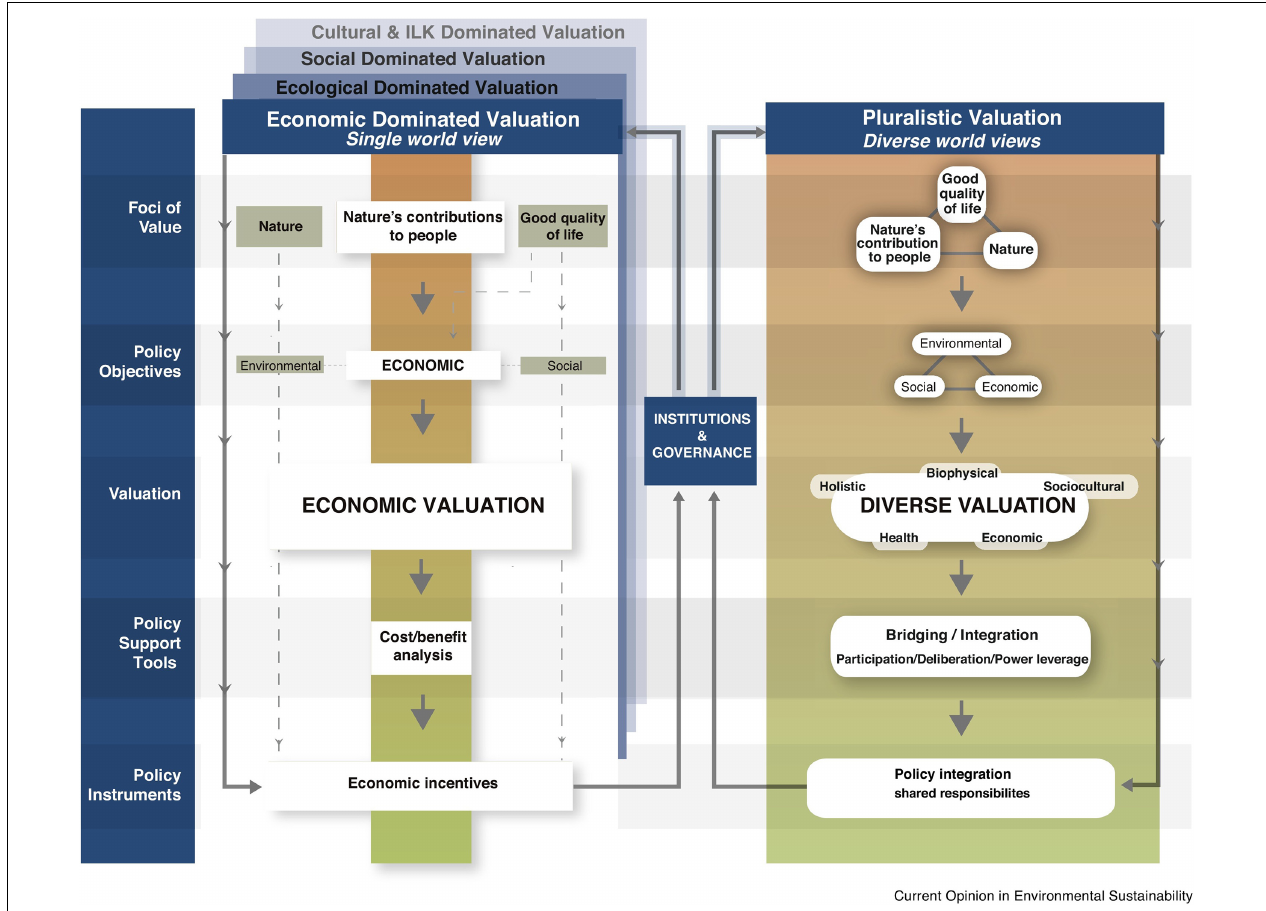
FIGURE 7 | Comparison between two contrasting valuation approaches. The right side represents a pluralistic valuation approach, whereas the left side of the panel focuses on unidimensional valuation approach, which is linked to the long-lasting and rooted idea that valuation equals monetarization. Such misconception generates value gaps which exacerbate social injustice. Reproduced from Pascual et al. (2017); open access under the Creative Commons Attribution-Non-commercial-No Derivatives License (CC BY NC ND